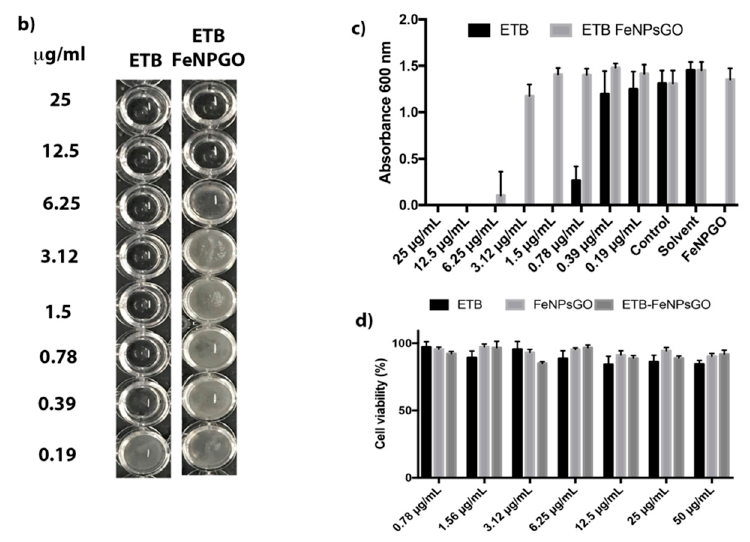
Figure 2. ( a ) REMA and SPOTi results based on ETBambutol (ETB) and multifunctional nanoformulation ETB-FeNPs-GO, tested on M. smegmatis ; ( b ) Complete biofilm inhibition in 96 well plate results based on ETB and ETB-FeNPs-GO tested on M. smegmatis according to their MIC; ( c ) Crystal violet quantification of concentration-dependent inhibition of biofilmsby ETB and ETB-FeNPs-GO; ( d ) Cell viability determined using MTT for the ETB, FeNPs-GO, and